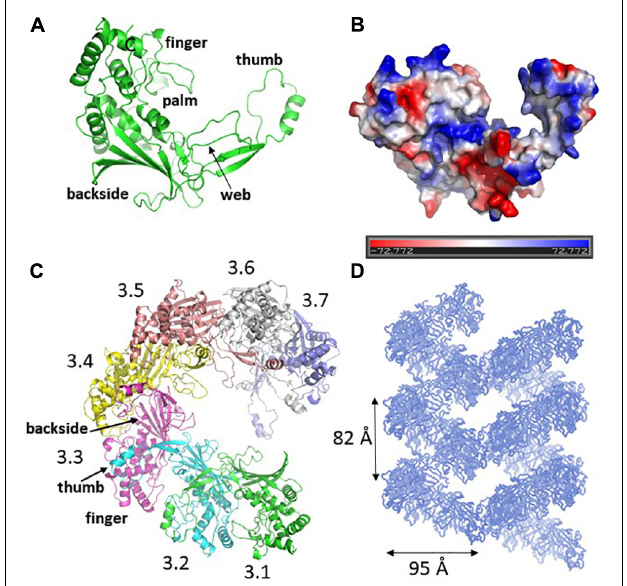
FIGURE 2 | Comparison of Csy3 subunits in the apo- and crRNA-bound Cascade backbone. (A) Superimposed structure of the two monomeric Csy3 structures from Z. mobilis and P. aeruginosa . The two Csy3 structures are differentiated with colors and the crRNA bound to the PaCsy3 is displayed with a ribbon diagram. (B) The superimposed hexameric Csy Cascade backbone. The ZmCsy3 molecules are displayed in green, while the PaCsy3 molecules are shown with alternating colors. The crRNA bound to the PaCsy3 backbone is displayed as a ribbon. Each Csy3 molecule is labeled from 3.1 at the 3 (cid:48) -hairpin to 3.6 at the 5 (cid:48) -handle. (C) A close-up view of the subunit interaction at the 3 (cid:48) -hairpin region. The 3 (cid:48) -hairpin-interacting PaCsy4 subunit in the P. aeruginosa Cascade complex is displayed as a black ribbon. (D) Close-up view of the subunit interaction at the 5 (cid:48) -handle region. The 5 (cid:48) -handle-interacting PaCsy1 subunit in the P. aeruginosa Cascade complex is displayed as a black